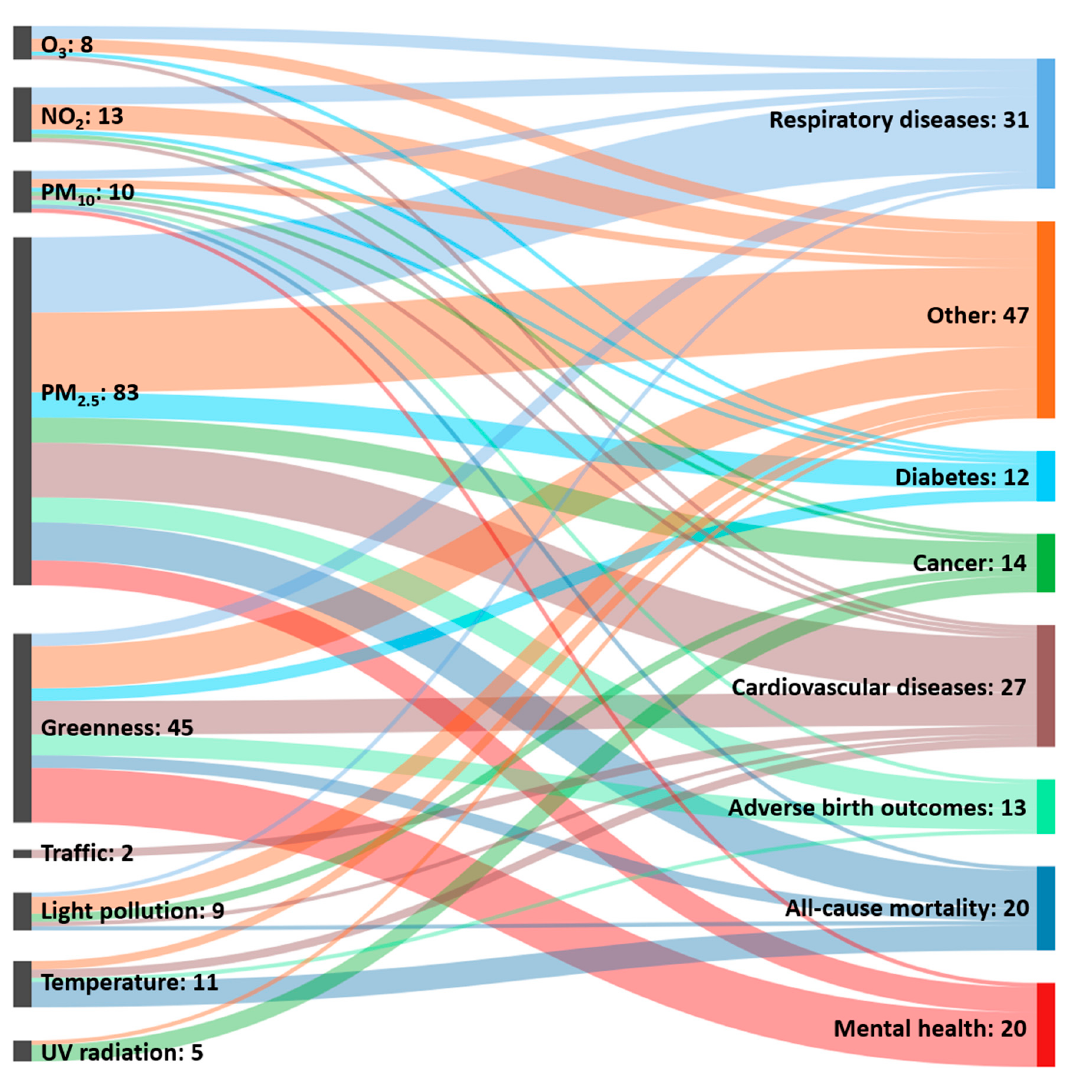
Figure 12. Correlations between EO-based environmental parameters and investigated NCDs. Note that atmospheric optical depth (AOD) is not shown on its own, it is accounted for by PM 2.5 and PM 10 . Similarly, air and land surface temperature are shown as one group. Investigating mostly measured land surface temperature (LST) and calibrating the results using air temperature measurements, resulting in one joint temperature product.